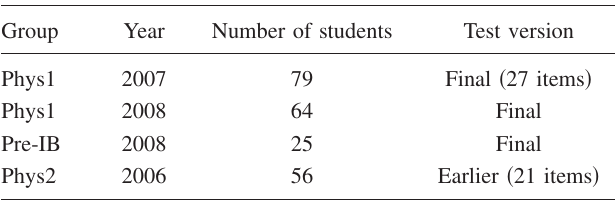
TABLE I. Groups and students (cid:1) n =224 (cid:2) who took the R-FCI as a pre- and post-test.